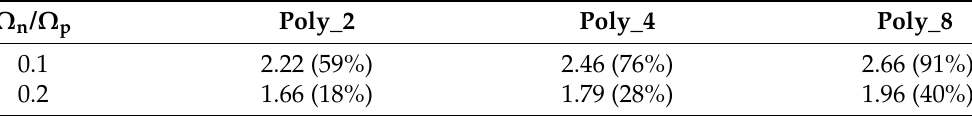
Table 2. Values of ln ¯ Q at ln ¯ λ tid = 5 for three different polytropic EOS models with spin ratios 0.1 and 0.2. The EOS parameters are chosen in such a way that the central proton fractions for 1.4 M (cid:12) stellar models are 0.02 (Poly_2), 0.04 (Poly_4), and 0.08 (Poly_8). The numerical values inside the parentheses are the percentage differences between the data and the predictions of the single-fluid Q-Love relation.